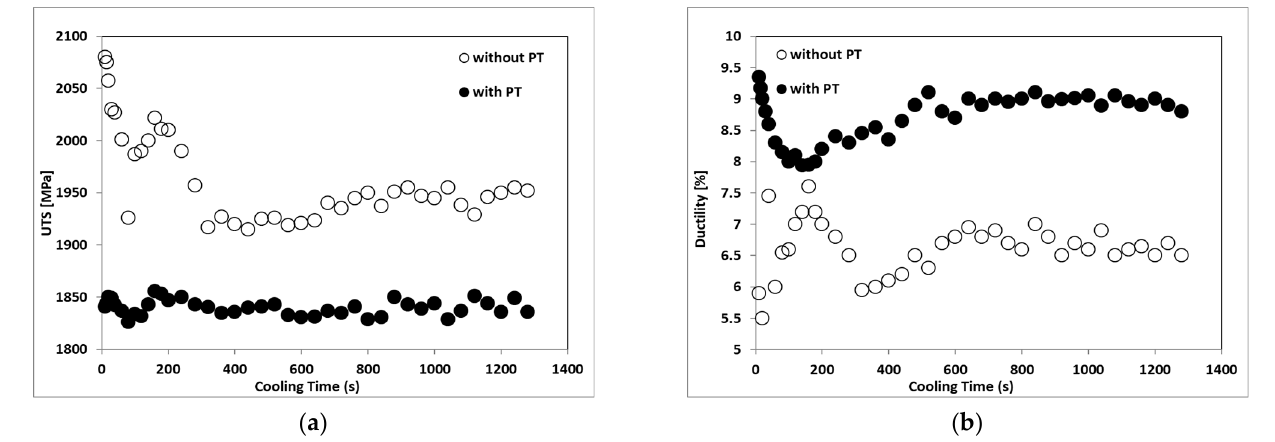
Figure 2. ( a ) Ultimate Tensile Strength and ( b ) Ductility versus cooling time.